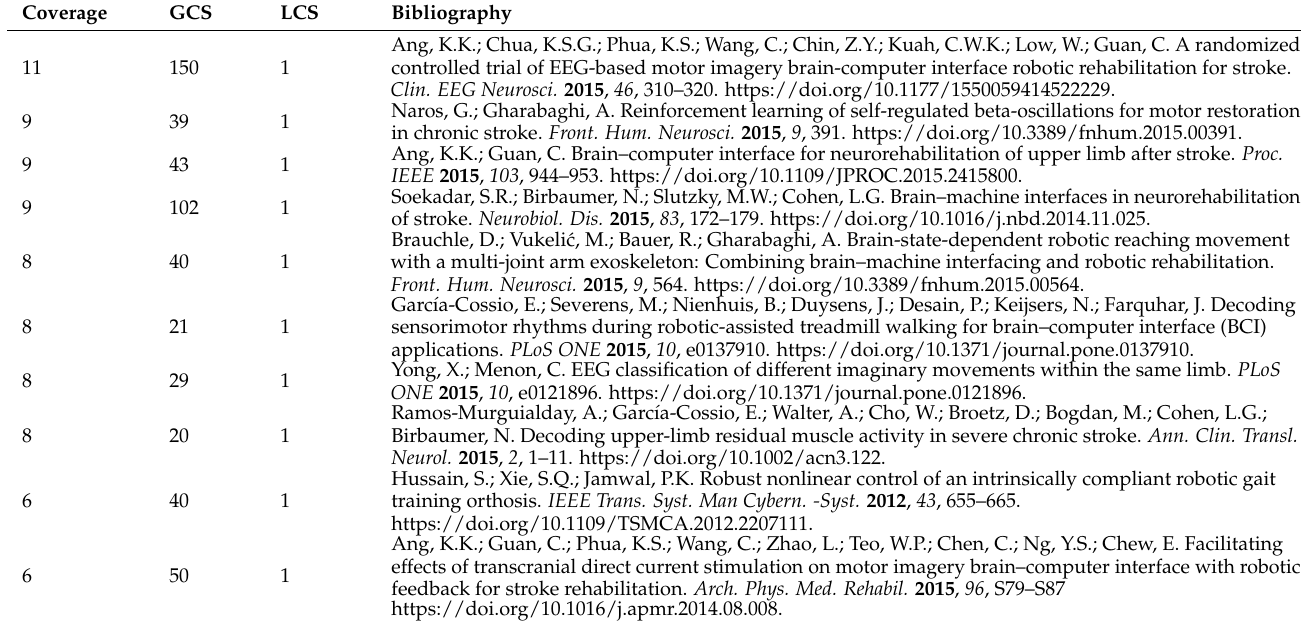
Table 5. Citing papers in Cluster